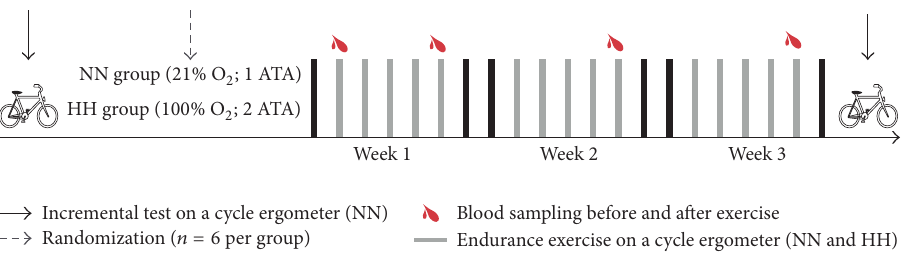
Figure 1: Schematic representation of training intervention. NN = normobaric normoxia; HH = hyperbaric hyperoxia. ATA = absolute